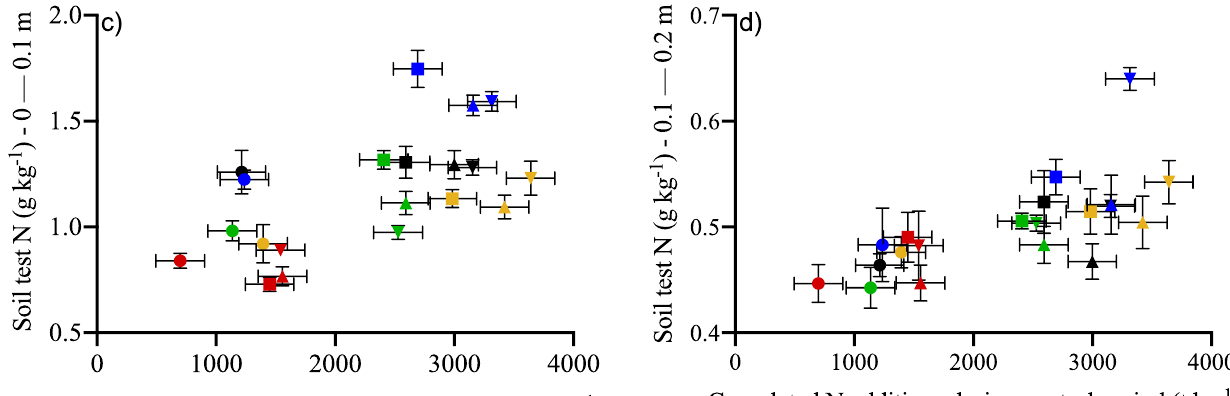
Figure 2. Change in soil C ( a , b ) and N ( c , d ) content during the 2009–2020 period in the 0–0.1 and 0.1–0.2 m layers, respectively, as impacted by treatments. Error bars represent standard errors of the means.